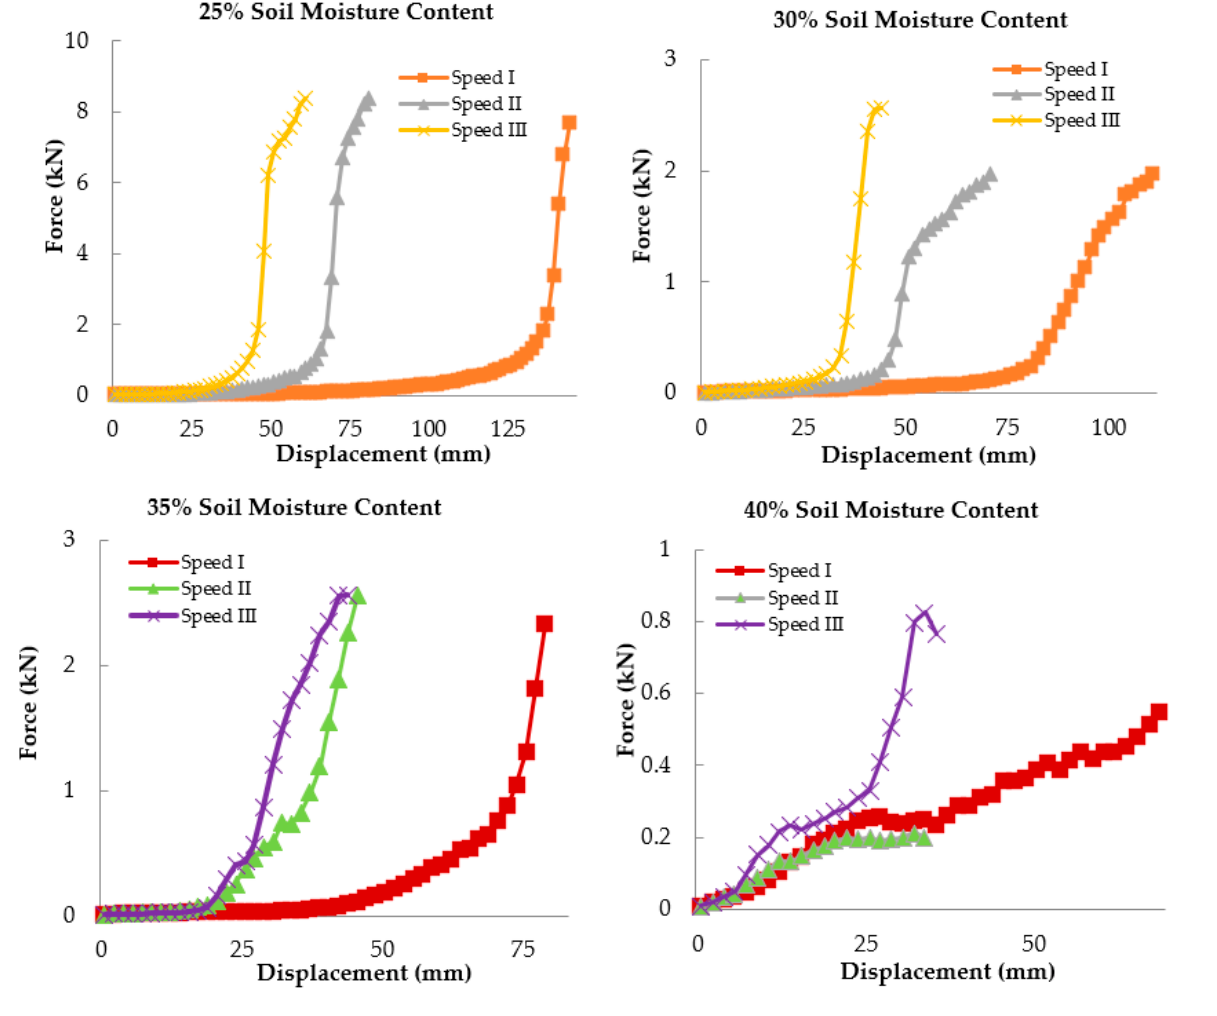
Figure 17. Results of compaction test.